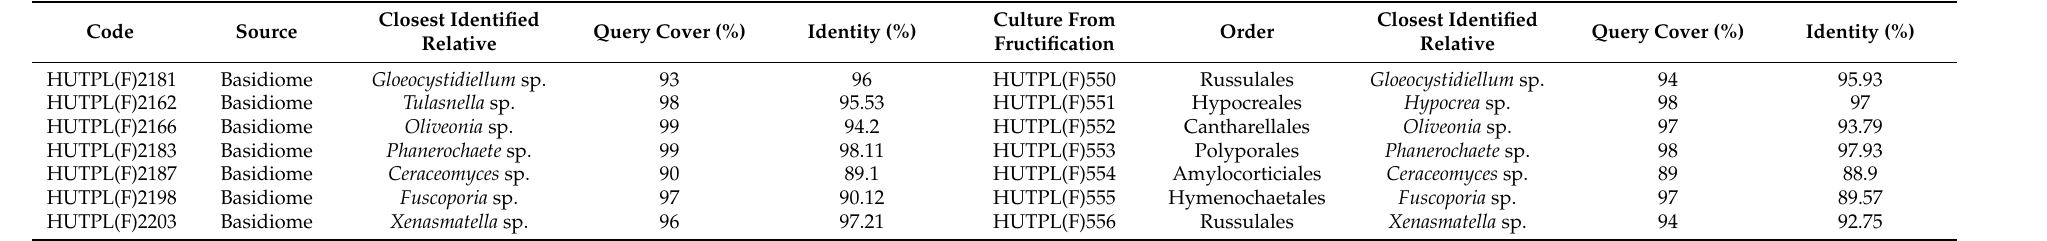
Table 2. BLAST similarity of basidiomata and fungal strains analyzed in this study.